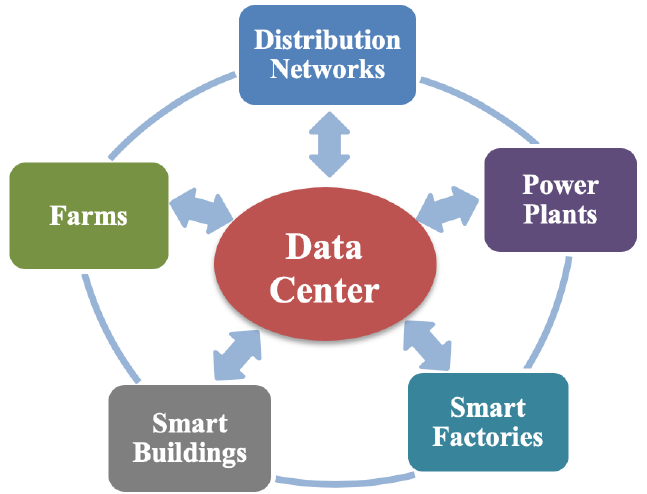
Figure 3. A centralized data connectivity in a smart city concept.